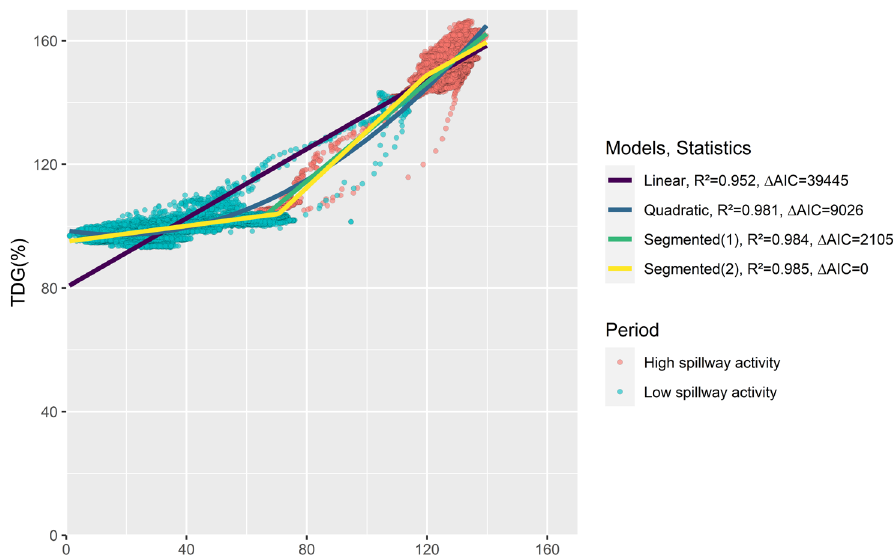
FIGURE 4 | TDG and DO saturations for periods with intense (red) and sporadic (blue) dam spillway activities. Four models were fitted to these data, all with TDG as a response and DO as a predictor. The models were: i) simple linear regression (Linear); ii) linear regression with quadratic effect of DO (Quadratic); iii) segmented linear regression, with 1 breakpoint and 2 segments (Segmented (1)); iv) segmented linear regression, with 2 breakpoints and 3 segments (Segmented (2)). The most parsimonious model with the lowest AIC was segmented regression